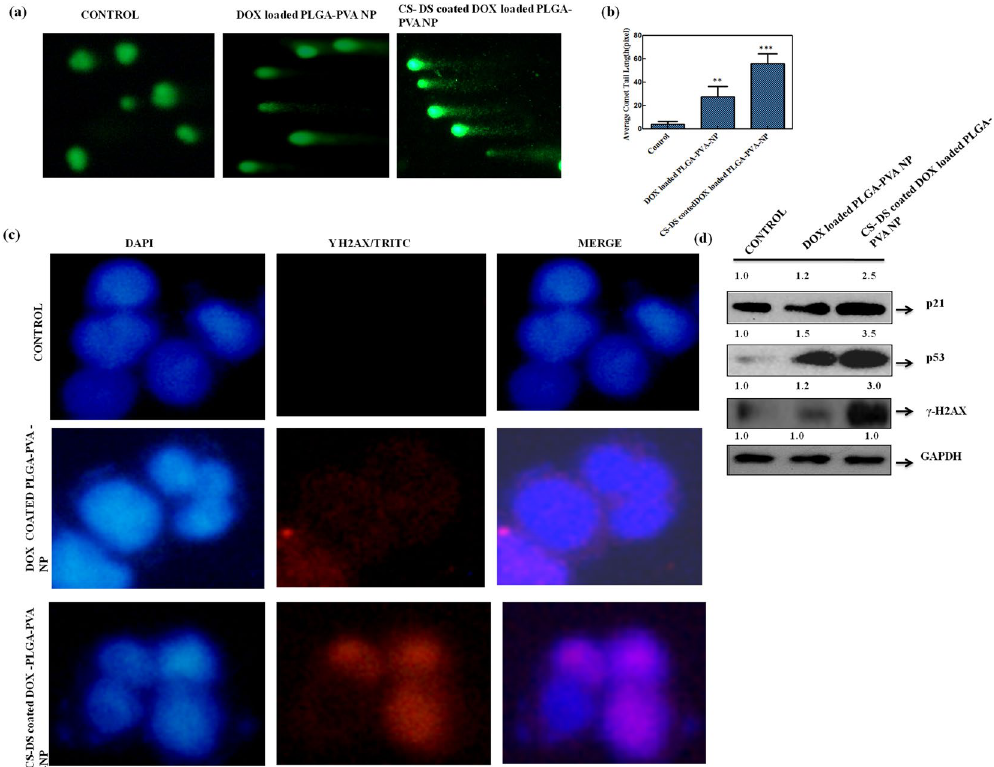
Figure 5. CS-DS coating on DOX loaded PLGA-PVA-NP induces DNA damage in MCF-7- DOX-R cells. (a) DNA damage (comet formation) increased after treatment with NPs. ( b ) Histogram representing average comet length in pixel. ( c ) Immunocytochemistry images of γ H2AX expressions in cells after treatment with NPs. Cells were stained with γ H2AX and nuclei were stained with DAPI and images were taken under fluorescence microscope (Nikon, Japan). ( d ) Expression of representative proteins involved in DNA